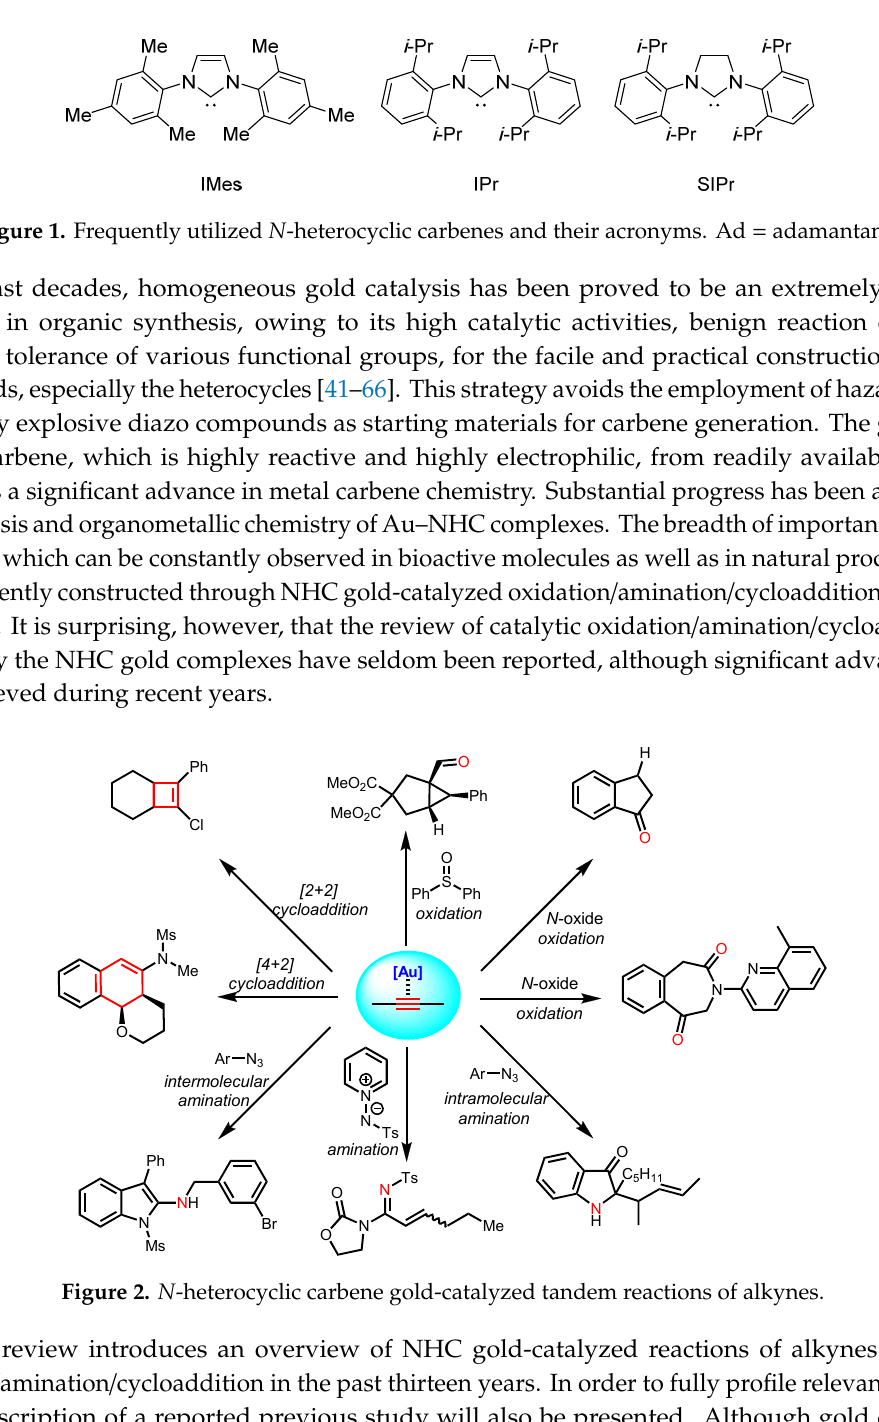
Figure 2. N -heterocyclic carbene gold-catalyzed tandem reactions of alkynes.